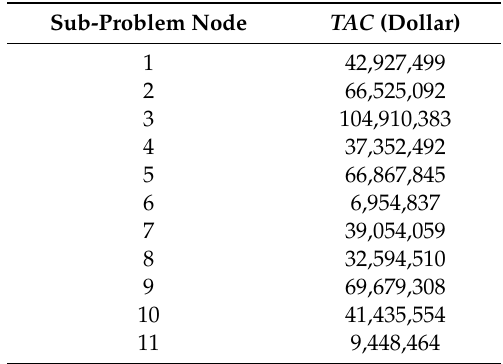
Table 10. Remaining sub-problem nodes’ costs of the petroleum refinery case after